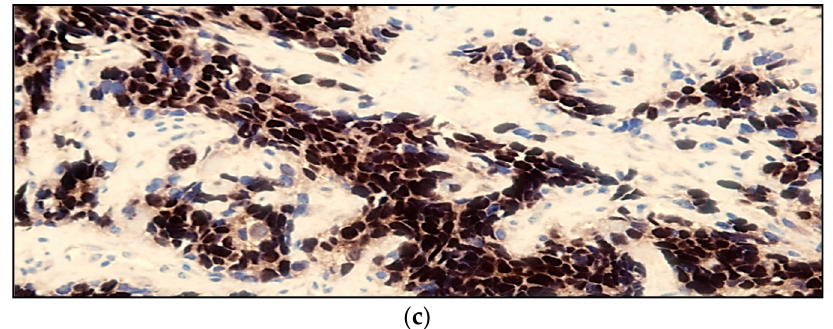
Figure 2. ( a ) Alveolar (ARMS)—Needle core biopsy from a soft tissue arm mass from a female teenager. A highly cellular “small round blue cell neoplasm” is seen infiltrating connective tissue in skeletal muscle. (H&E stain). ( b ) At high power, tumor cells are tightly packed, with variable molding cell membranes, small to moderate amount of delicate cytoplasm, relatively uniform round nuclei, delicate to “salt-and-pepper” chromatin, mostly inconspicuous nucleoli, and scattered mitoses (H&E stain). ( c ) Immunohistochemical stain for myogenin strongly highlights nuclei of the overwhelming majority of infiltrating tumor cells, densely packed. In contrast, nuclei of the collagenous connective tissue in the background remain appropriately negative.